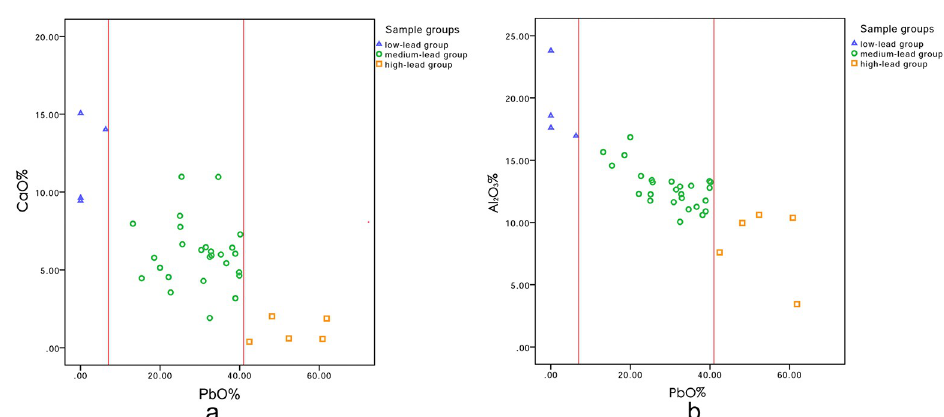
Fig 2. Distribution map of lead content in glaze of samples. (a) The lead-calcium distribution map. (b) The lead- aluminum distribution map.